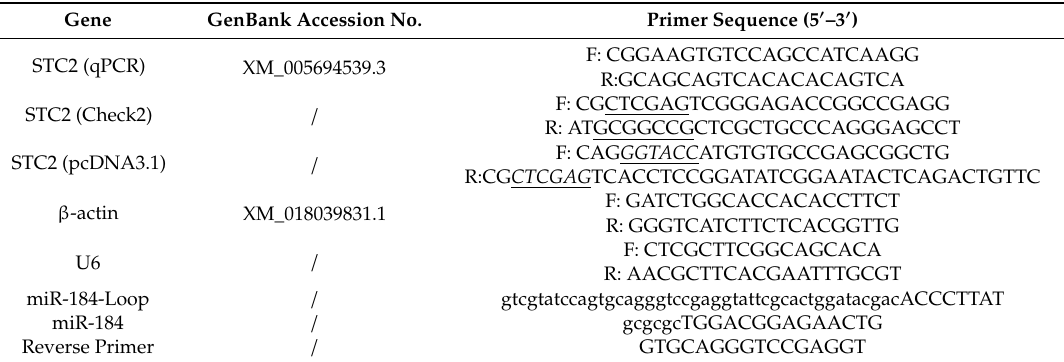
Table 1. All primers used in this